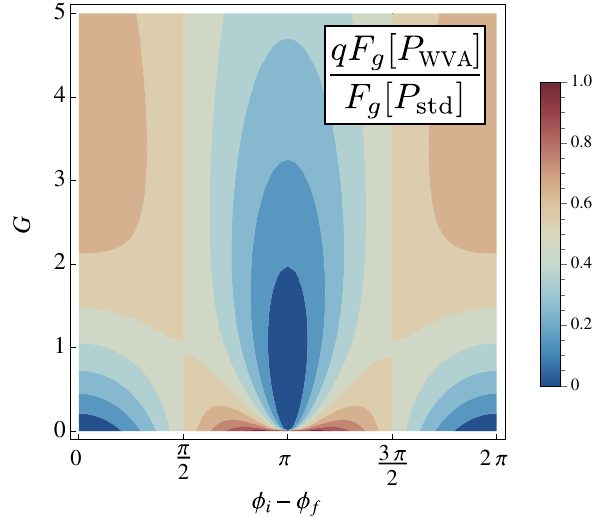
FIG. 5 Contour plot of the corrected ratio of Fisher information for the weak-value-amplification strategy to Fisher information for the standard strategy, expressed as a function of the meas- urement strength G and the angle between pre- and postselection ϕ − ϕ . The plot relates to imaginary weak i f